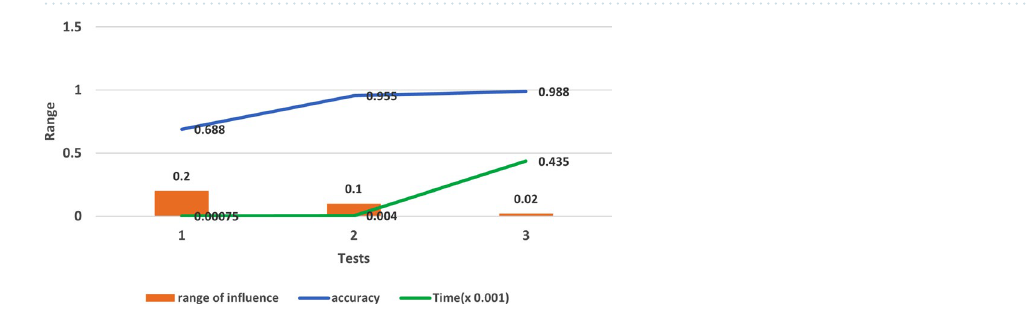
Figure 4. The impact of range of influence on accuracy in tests 1, 2 and